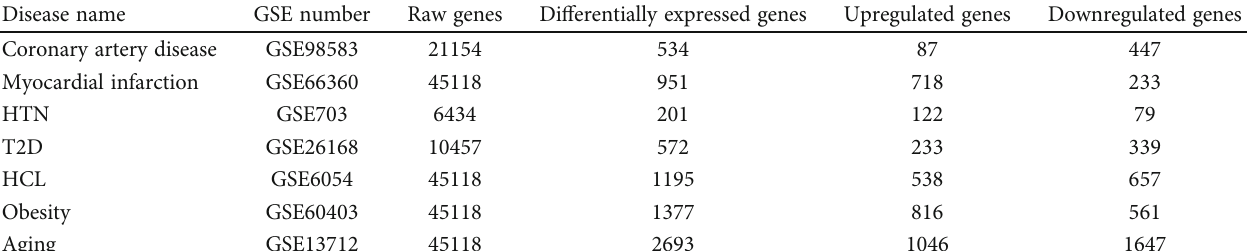
Table 2: Number of identi fi ed DEGs for CVD and its risk factors.